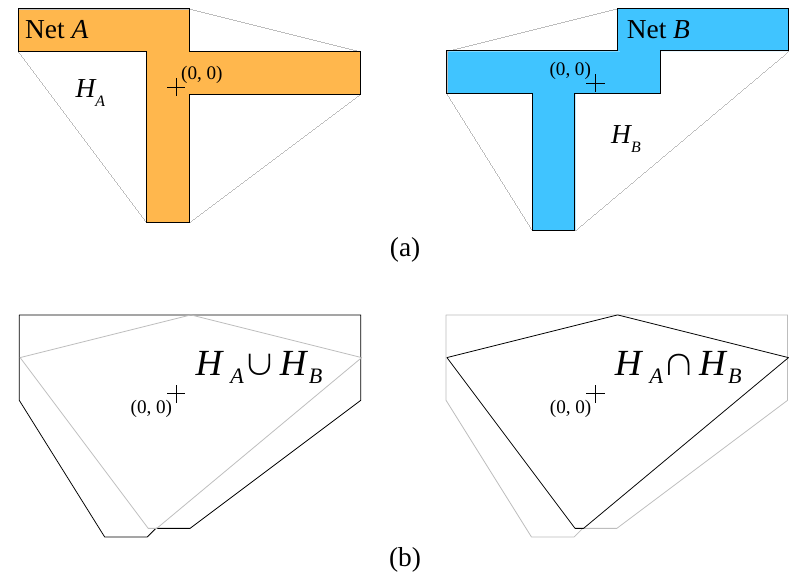
Figure 2. ( a ) Two nets A and B and their convex hulls H A and H B . The cross denotes the net’s centroid after shifting to ( 0,0 ) . ( b ) Union H A ∪ H B and intersection H A ∩ H B of those